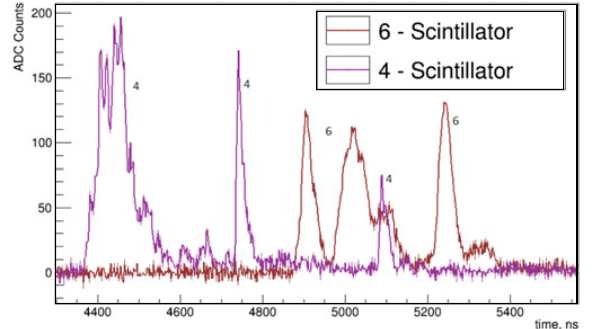
Figure 5. Sample ‘standard’ event as seen by the HT detector system.